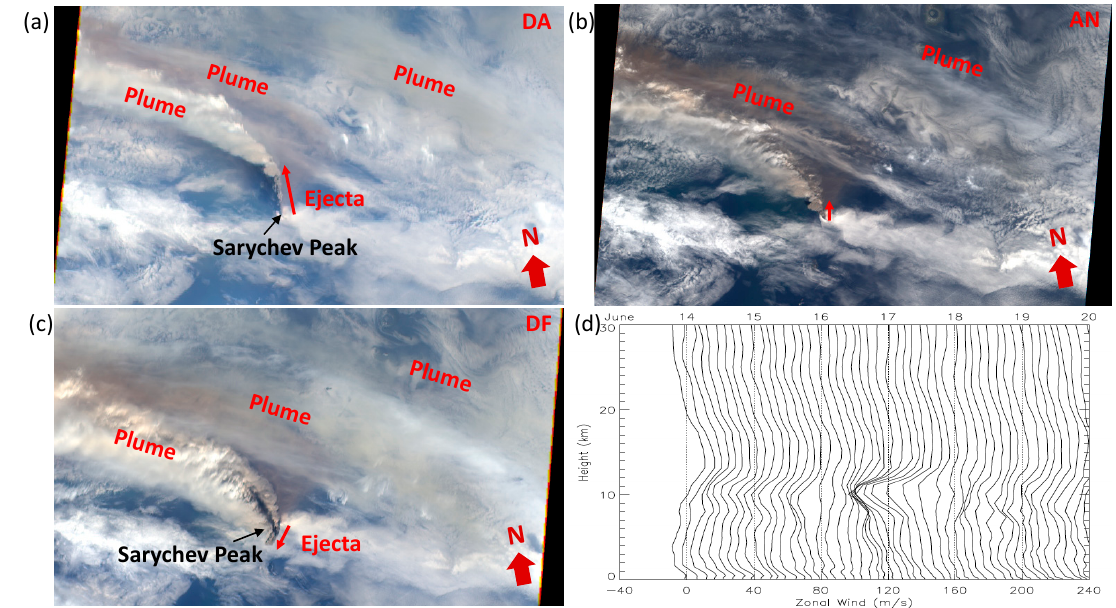
Figure 2. The Sarychev eruption captured by MISR ( a ) DA (70 ◦ aft), ( b ) AN (nadir), and ( c ) DF (70 ◦ forward) cameras on 16 June 2009 at UTC 00:53; and ( d ) in MERRA2 3-hourly zonal winds. Successive MERRA2 wind profiles are shifted by 5 m/s for illustration. The parallax of the ejecta (grey tower) is clearly seen in the three different angular views, shooting above the white cloud deck. Ash/Aerosol plumes are evident in the region above white clouds. MERRA2 zonal wind profiles near Sarychev show a large anomaly on June 16 at ~12 km. During 14–20 June, the zonal winds are westward in most of the troposphere and eastward in the UTLS.